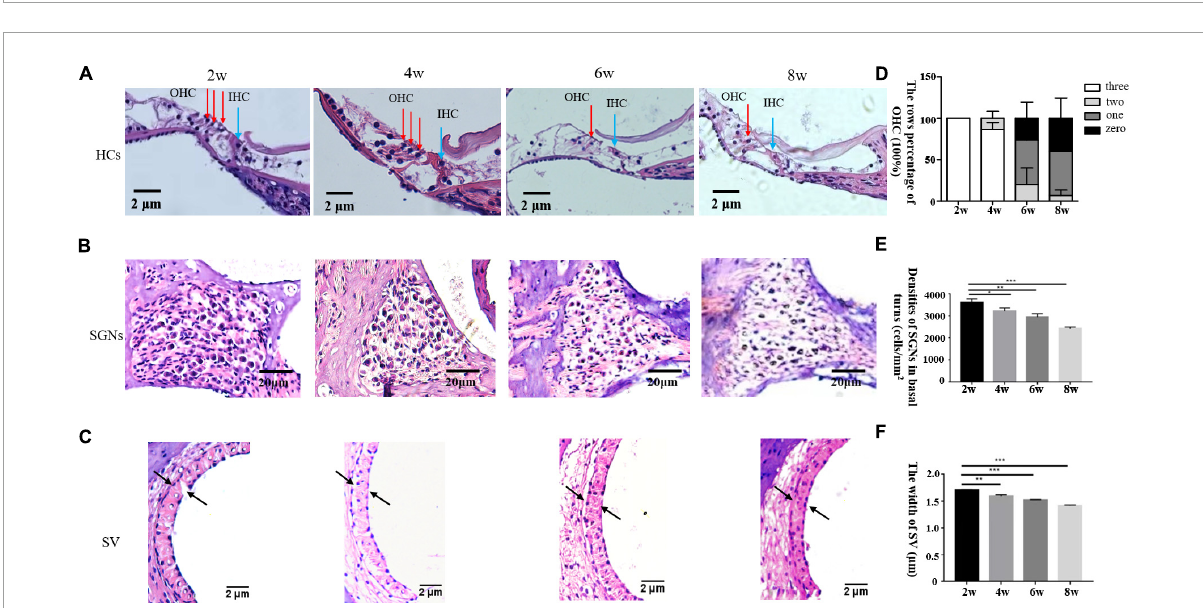
FIGURE2 (A–C) Morphological changes in the cochlea after H&E staining in DBA/2J mice. OHC mean outer hair cell (red arrow), IHC means inner hair cell (blue arrow) × 200. Panel D shows the rows percentage of OHC (100%). Panels E,F show the statistical analysis of DBA/2J SGNs density and the SV width of mice at different weeks of age (* P < 0.05, ** P < 0.01, *** P <